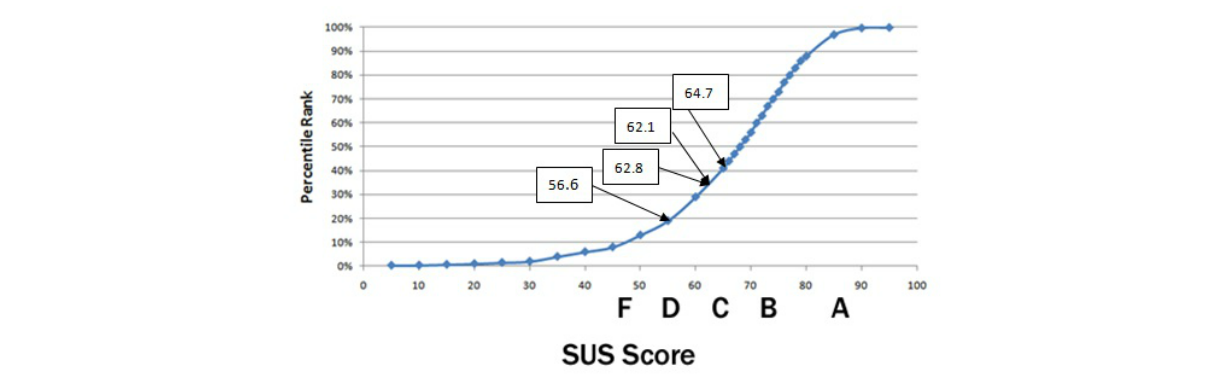
Figure 4. SUS scores of the four case studies of evaluation of mEducator 3.0 MELINA+ on the SUS